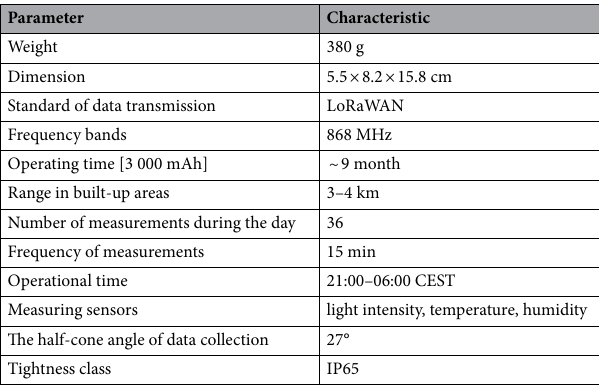
Table 1. Selected technical parameters of the device for measuring light pollution of the night sky.